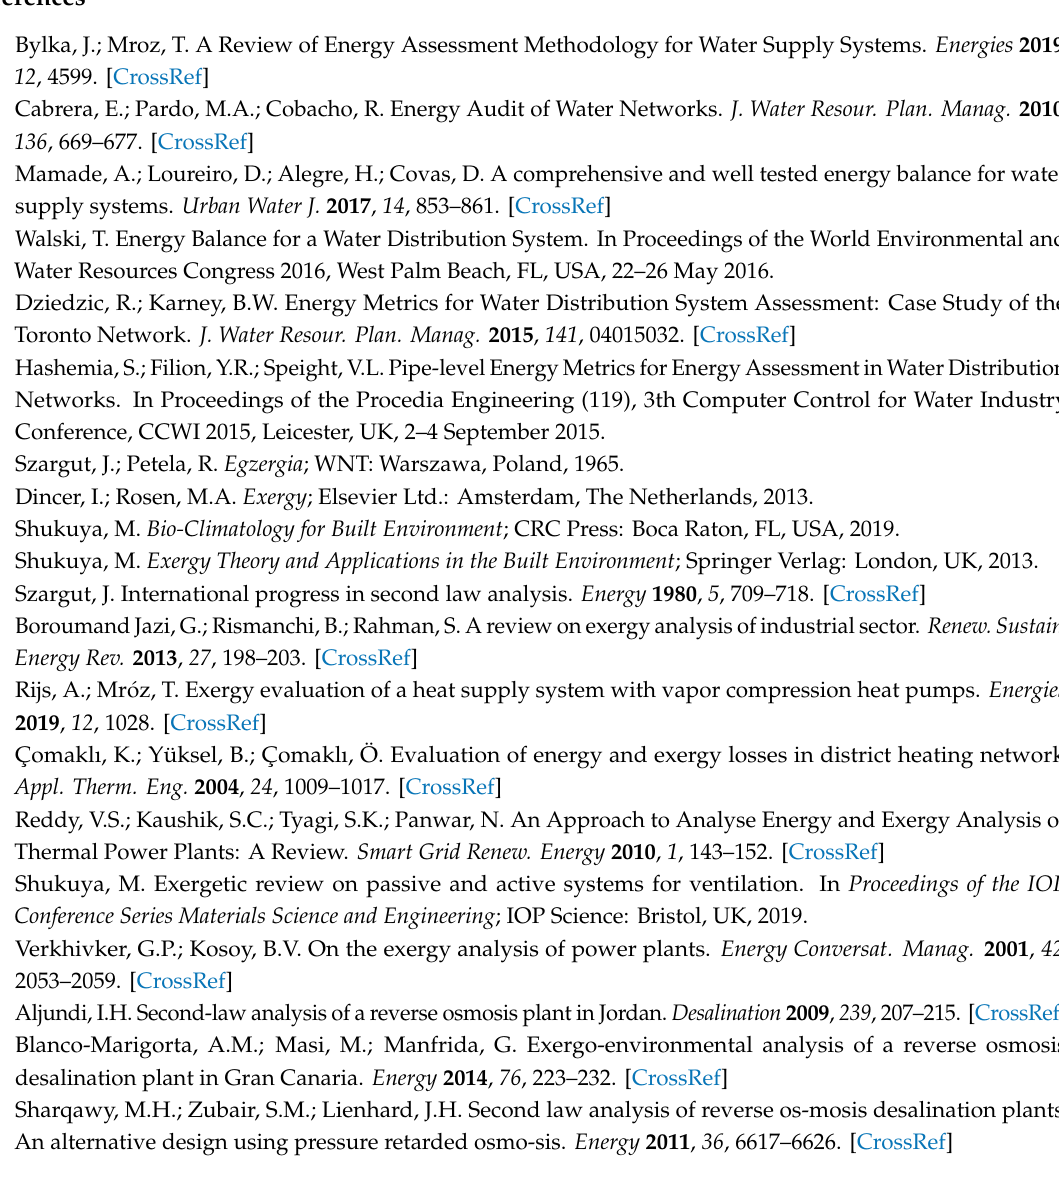
Figure S1: Water supply system–unit exergy losses for pipe transport; Figure S2: Water supply system–unit exergy losses for nodes report; Figure S3: Water supply system–unit exergy losses for nodes report (heat map); Figure S4: Water treatment station–unit exergy losses report. Figures S1–S4 are available in attachment 1. A list of used symbols can be found in attachment